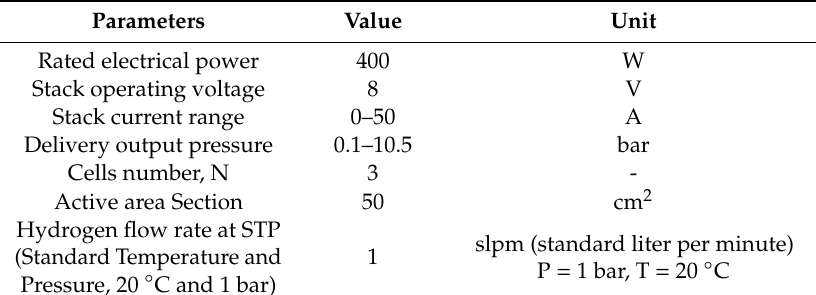
Figure 15. The I–V characteristic curve of a PEMEL with two di ff erent modeling (i.e., nonlinear Figure 15. The I-V characteristic curve of a PEMEL with two different modeling (i.e., nonlinear and and linear). linear). Table 1. Specifications of the Table 1. Specifications of the PEMEL.